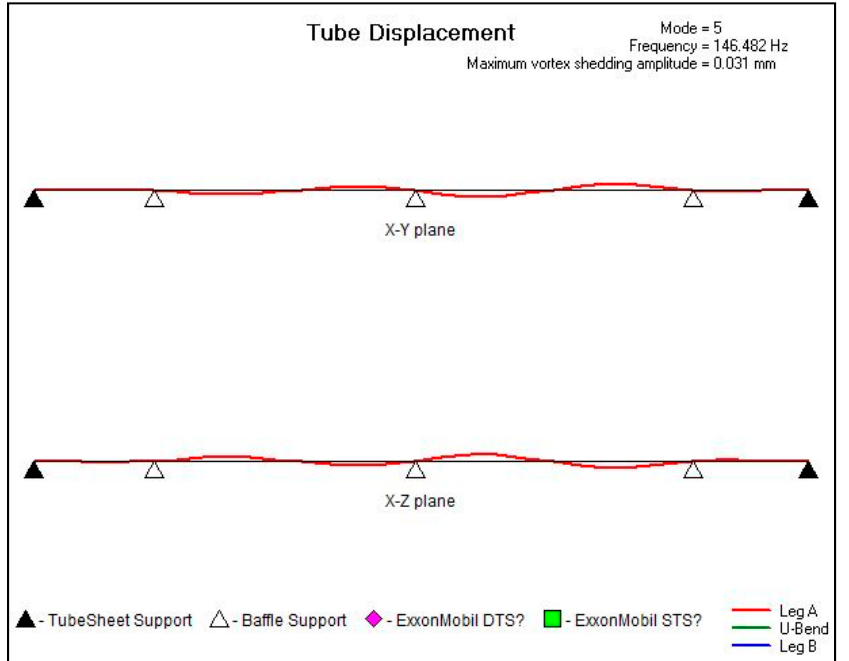
Figure 10. Tube displacement profiles of modes 5 and 6, 146.48 Hz.